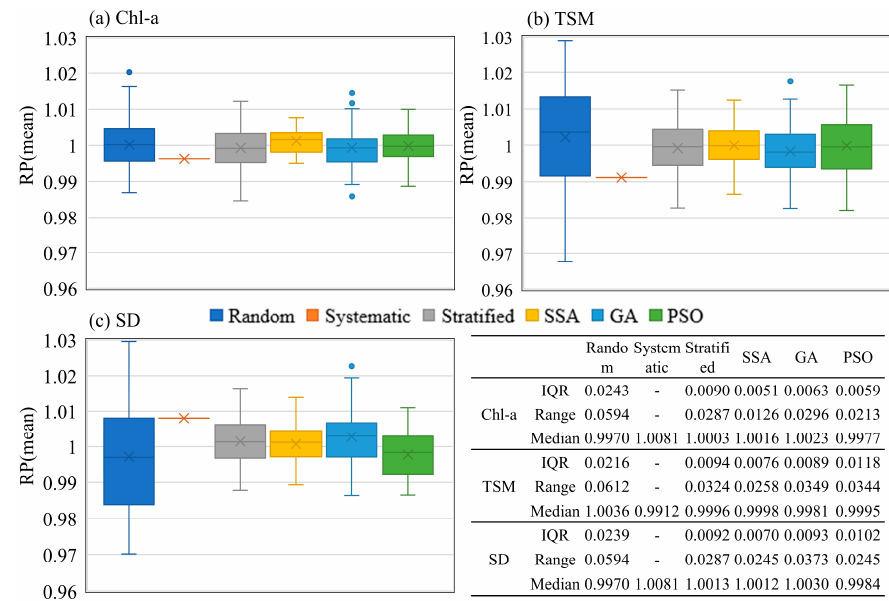
Figure 5. Boxplots of 𝑅𝑃 (cid:3040)(cid:3032)(cid:3028)(cid:3041) for 100 simulations for each sampling method, Chl-a ( a ), TTS ( b ), SD